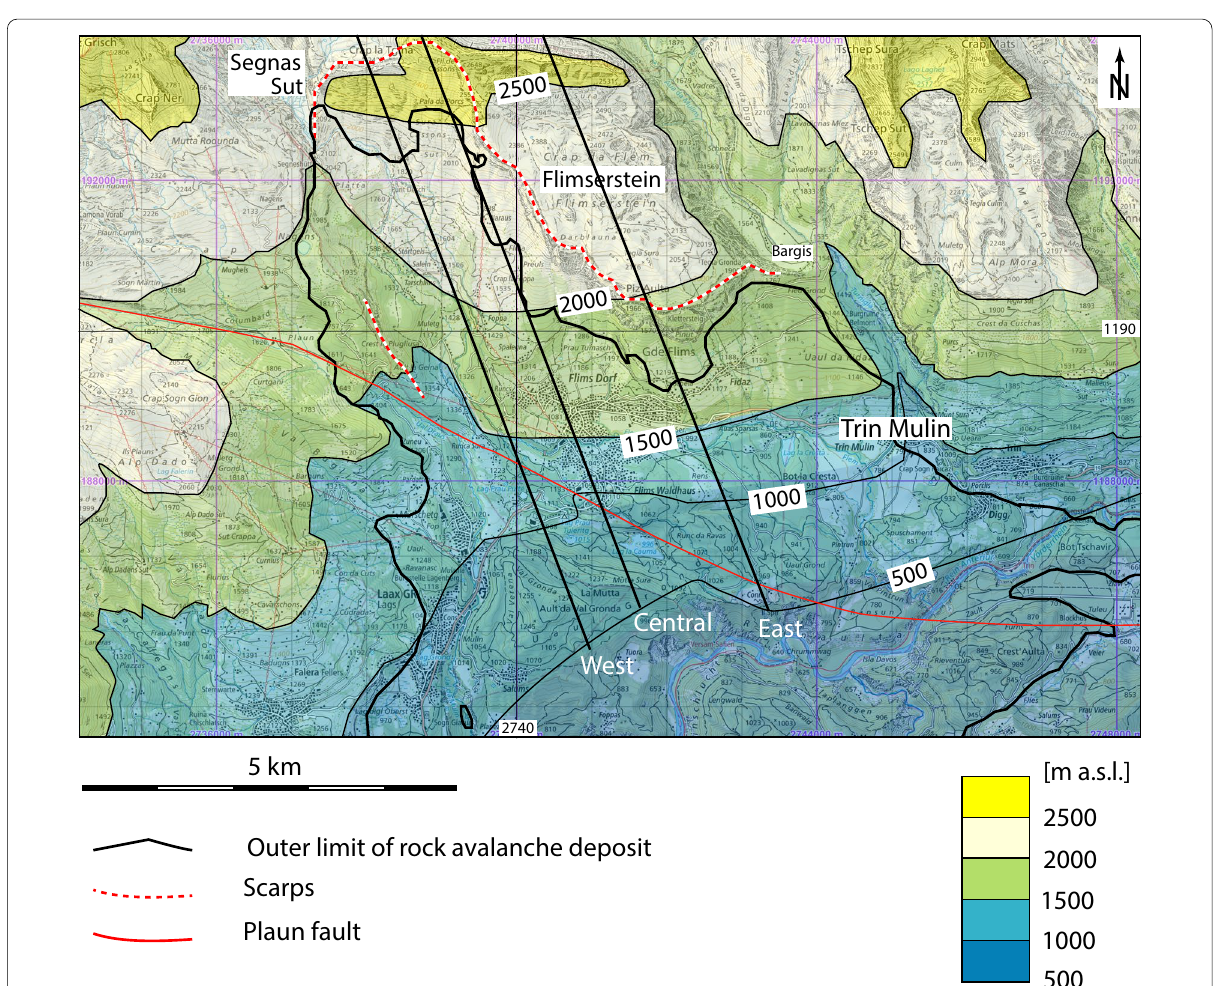
Fig. 6 Palaeo-topography of the source area of the Flims rock avalanche shown as map with topographic contours. West, Central, East: traces of cross-sections shown in Fig.